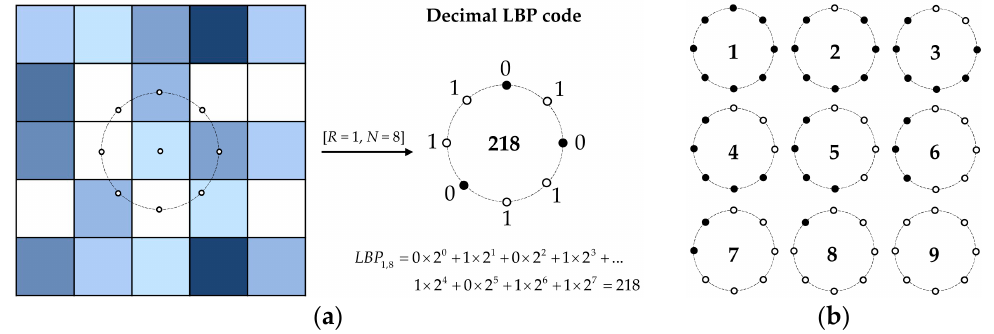
Figure 2. An example of generating the decimal LBP code for a pixel using N = 8 neighboring pixels at the radius R = 1 pixel: solid and hollow markers correspond to the pixels with higher and lower values as compared to the central pixel ( a ). The nine uniform binary patterns used to compute the uniform LBP features using N = 8 neighboring pixels as proposed in [54] ( b ).